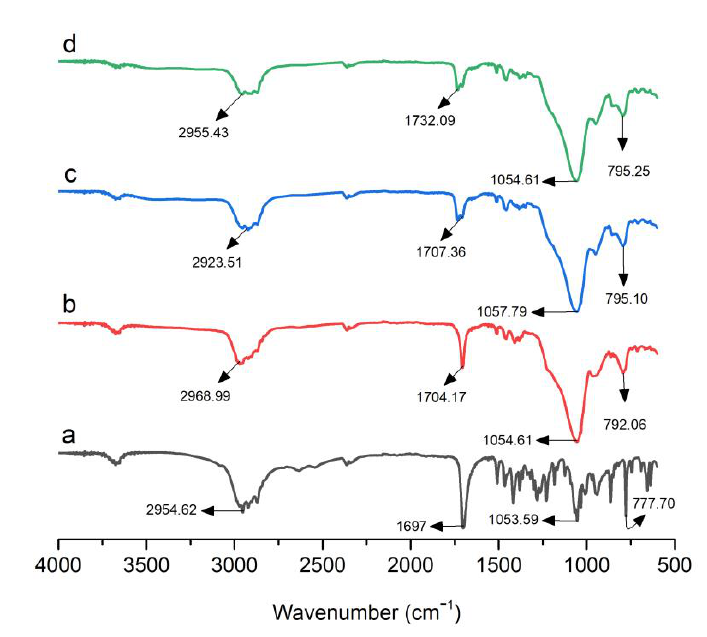
Figure 2. FTIR spectra of ( a ) Dex, ( b ) S1, ( c ) S18, and ( d ) S23. The FTIR spectra did not display any significant changes in the peaks of Dex in opti- mized formulations, suggesting a lack of incompatibility between the drug and carriers. Furthermore, hydrogen bonding between Dex and carrier molecules in the optimized for- mulations restricted drug recrystallization [38]. 3.3. Powder X-ray Diffraction Analysis X-ray diffraction was used to examine the physical state of Dex and optimized for- mulations as presented in Figure 3. The pure Dex showed its diffraction peaks at 16.17°, 17.67°, 18.58°, 19.48°, and 21.17°. There were also a few dull peaks after 21.17°. Similar peaks were reported in the literature, indicating the crystalline nature of Dex [39].